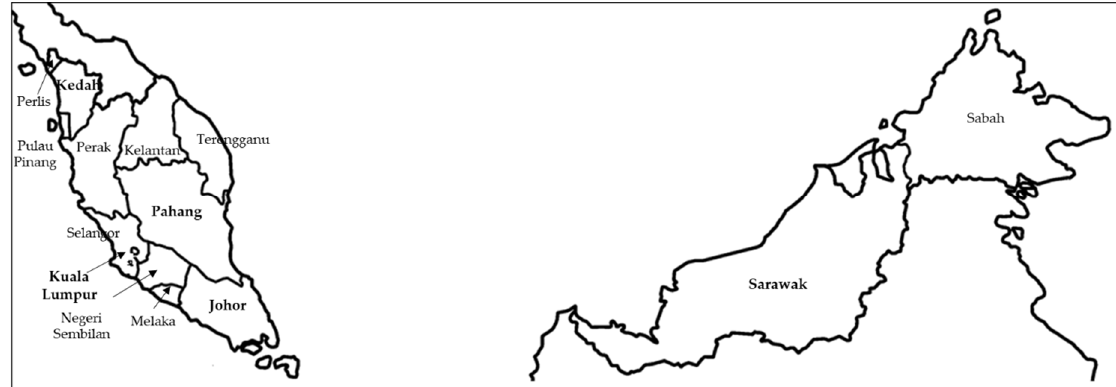
Figure 1. Map of states in Malaysia.